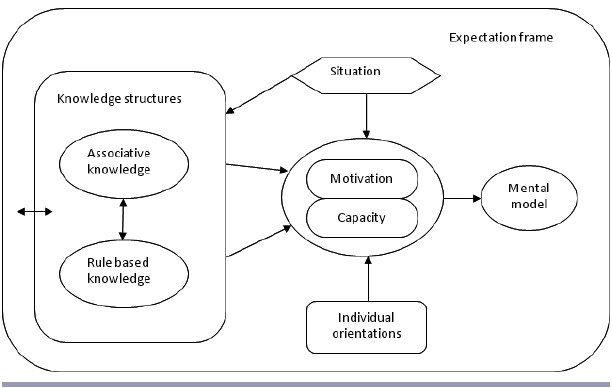
Fig. 1. Conceptual representation of the core dimensions of the mental models concept and their interrelationships. To simplify as much as possible, feedbacks such as those between mental models and knowledge structures are not